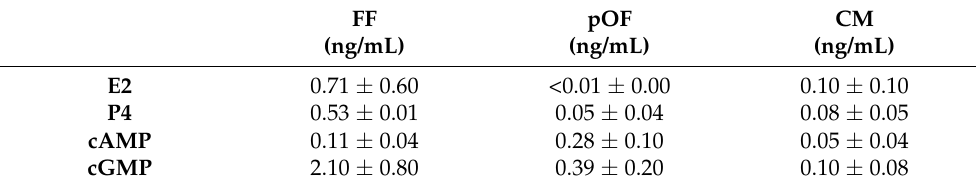
FF: Follicular fluid; pOF: periovulatory oviductal fluid; CM: secretions of the cumulus cells. Results are expressed as mean ± standard deviation